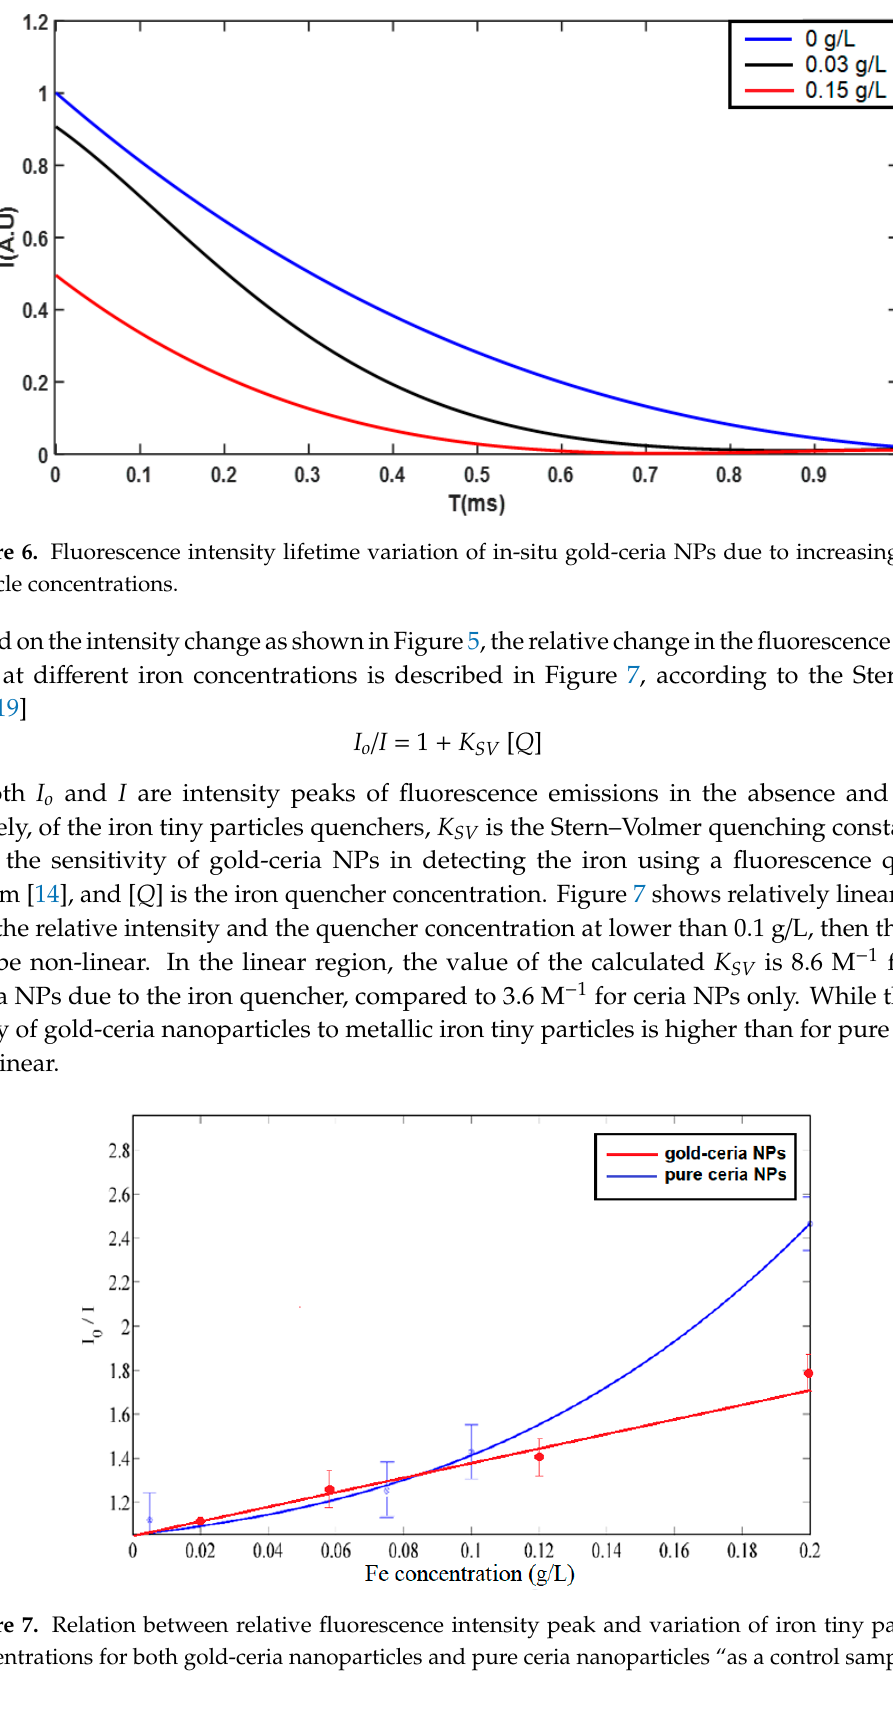
Figure 5. Fluorescence intensity quenching of in-situ gold-ceria NPs due to increasing iron particle concentrations “in g/L”.